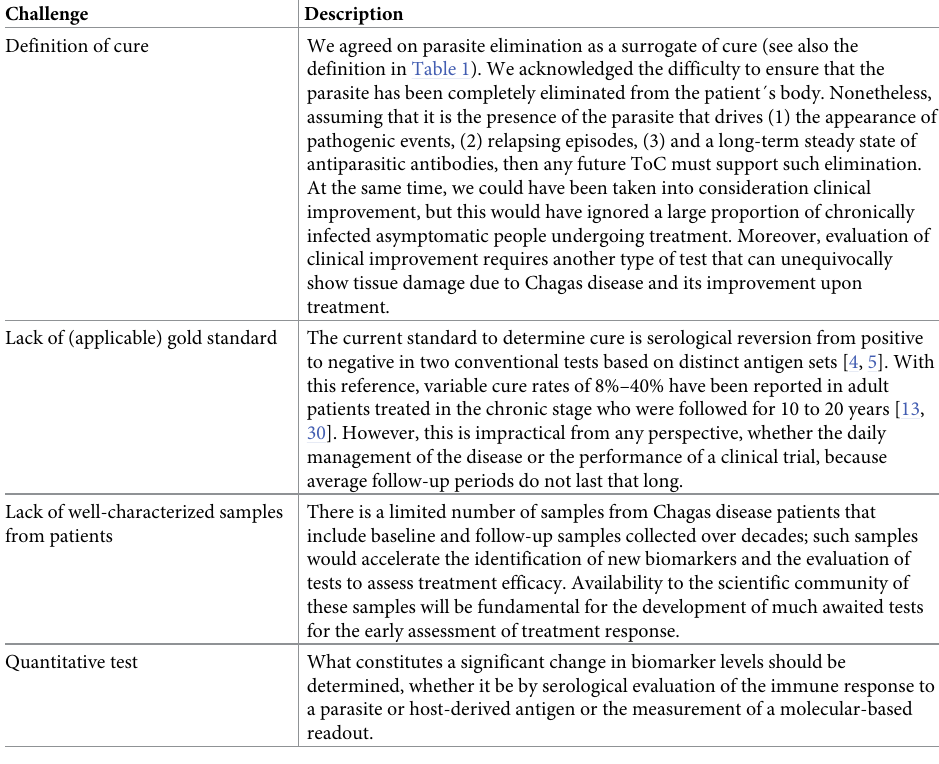
Table 3. Challenges towards the development and evaluation of a test for the early assessment of treatment effi- cacy in Chagas disease